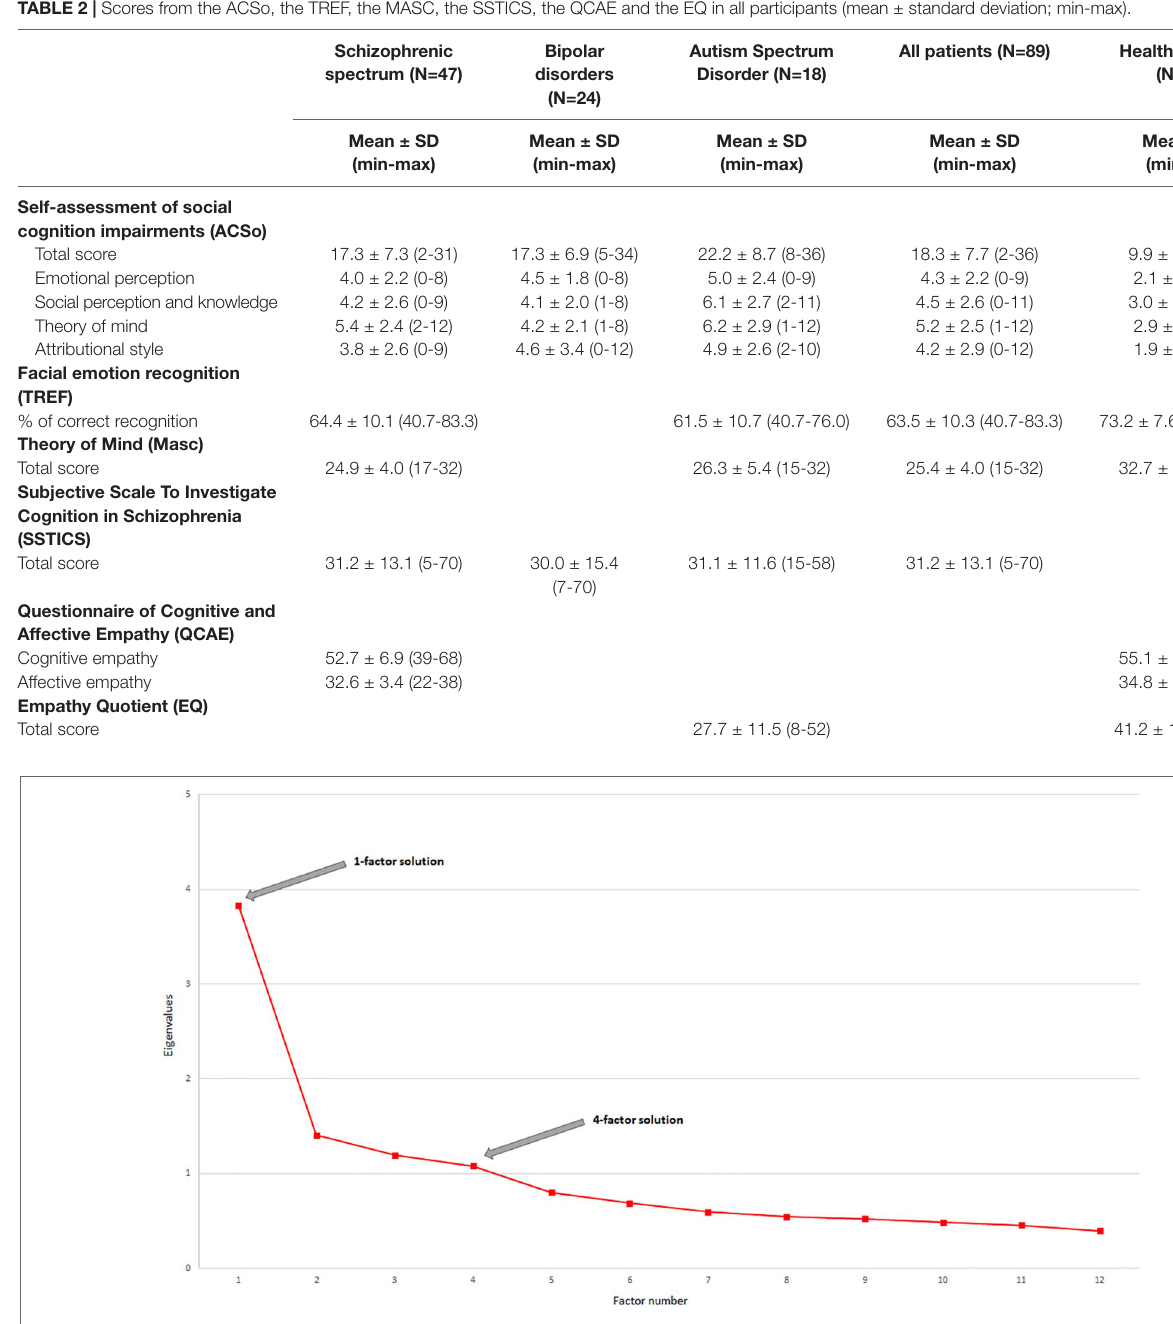
FIgURe 1 | Scree plot of the eigenvalues for the 12 items of the ACSo. The two breaks in the slope after the first and the fourth eigenvalue are indicated by the